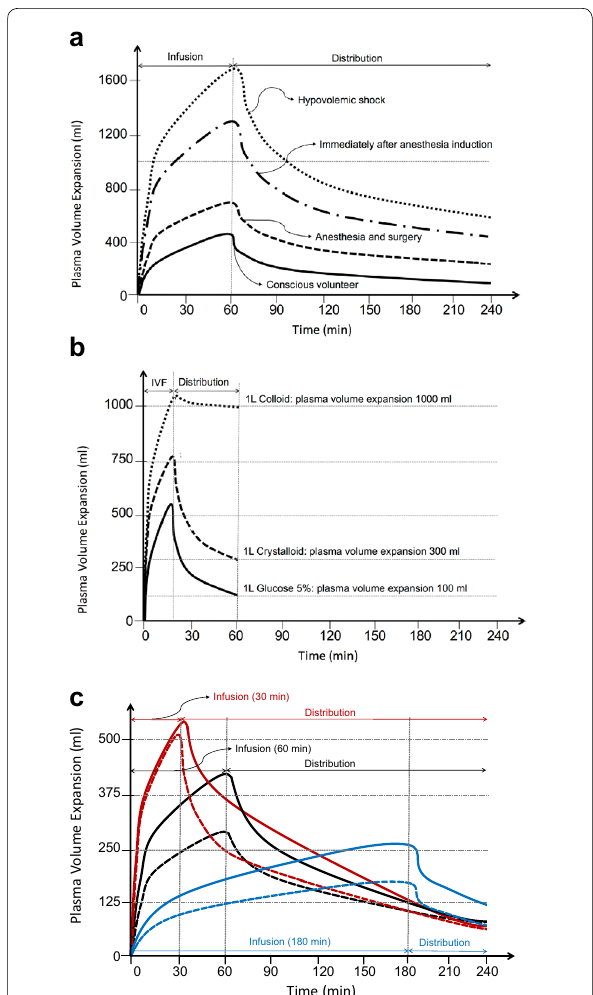
Fig. 3 Pharmacokinetics and pharmacodynamics fluids. Original art‑ work based on the work of Hahn R [29, 43]. a Volume kinetic simula‑ tion. Expansion of plasma volume (in mL) after intravenous infusion of 2 L of Ringer’s acetate over 60 min in an adult patient (average weight 80 kg), depending on normal condition as conscious volunteer (solid line), during anaesthesia and surgery (dashed line), immediately after induction of anaesthesia due to vasoplegia and hypotension with decrease in arterial pressure to 85% of baseline, (mixed line) and after bleeding during haemorrhagic shock with mean arterial pressure below 50 mmHg (dotted line) (see text for explanation). b Volume kinetic simulation. Expansion of plasma volume (in mL) is 100, 300 and 1000 mL, respectively, after 60 min following intravenous infu‑ sion of 1 L of glucose 5% over 20 min in an adult patient (solid line), versus 1 L of crystalloid (dashed line), versus 1 L of colloid (dotted line) (see text for explanation). c Volume kinetic simulation. Expansion of plasma volume (in mL) after intravenous infusion of 500 mL of hydroxyethyl starch 130/0.4 (Volulyte, solid line) versus 1 L of Ringer’s acetate (dashed line) when administered in an adult patient (average weight 80 kg), over 30 min (red) versus 60 min (black), versus 180 min (blue). When administered rapidly and as long as infusion is ongoing, the volume expansion kinetics are similar between crystalloids and colloids, especially in case of shock, after induction and anaesthesia and during surgery (see text for